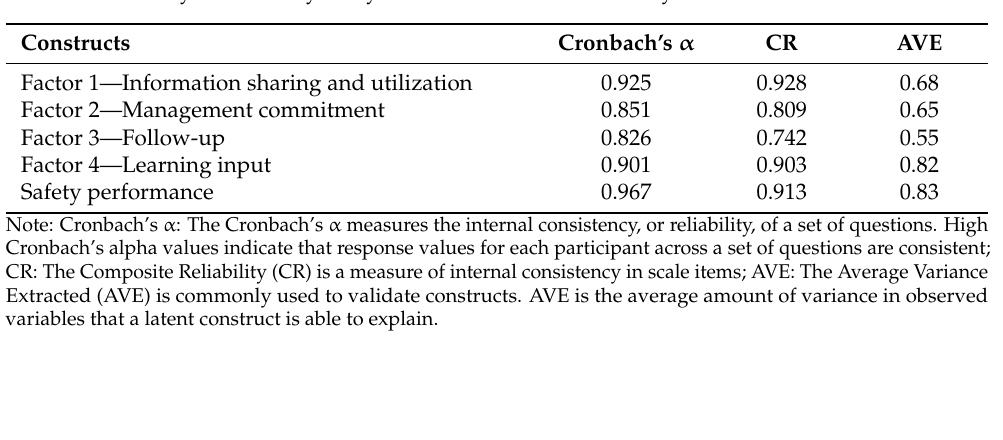
Table 6. Reliability and validity analysis for constructs in this